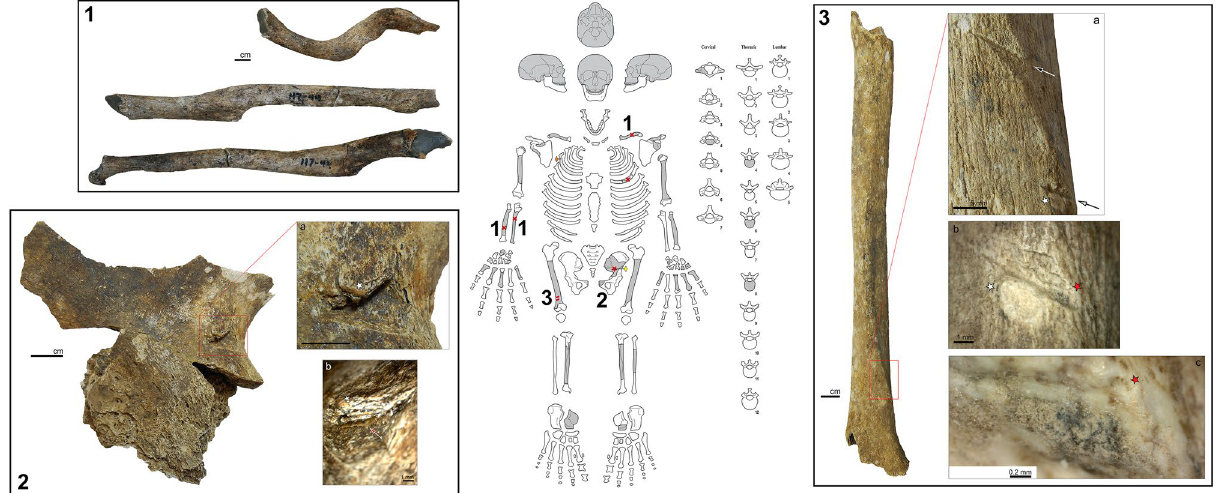
Figure 4. Location and images of the observed osseous lesions on JS 44. Center: schematic scheme of JS 44 ′ s skeletal preservation. Grey parts represent preserved bones, striped areas are missing bone, crisscross areas are bone whose exact anatomical position is unknown, full star = unhealed puncture, dash = drags traces of projectile impacts, time sign = healed fracture, yellow diamond = embedded artefact in a puncture, orange diamond = embedded artefact in lost bone. Box n°1: Healed fractures on JS 44. From top to bottom, left clavicle superior view, right radius anterior view and right ulna anterior view. Box n°2: Lateral view of the left pelvis of JS 44 with a projectile impact puncture with an embedded lithic flake. a = red rectangle close up of the PMI with white star as reference point for the magnified area b. b = microscopic view of the puncture showing the laminated aspect of the superior border and the lithic artefact inside the puncture indicated by the red arrow (magnification 30x). Box n°3: Double parallel drags on JS 44 located on the posterior surface of the right femur diaphysis, at the level where the lateral supracondylar line, which delimitates the lateral part of the popliteal plane, meets to lateral side of the femoral diaphysis. a = red rectangle close up showing the two parallel drags and the direction of the projectile with the arrows. White star as reference point for the magnified area b. b = microscopic close up on the distal drag showing the flaking of the superior border at the origin of the drag. Red star as reference point for the magnified area c (magnification ×45). c = composite microscopic view of the proximal part of the distal drag displaying the wide flat bottom of the groove and the parallel microstriations (magnification